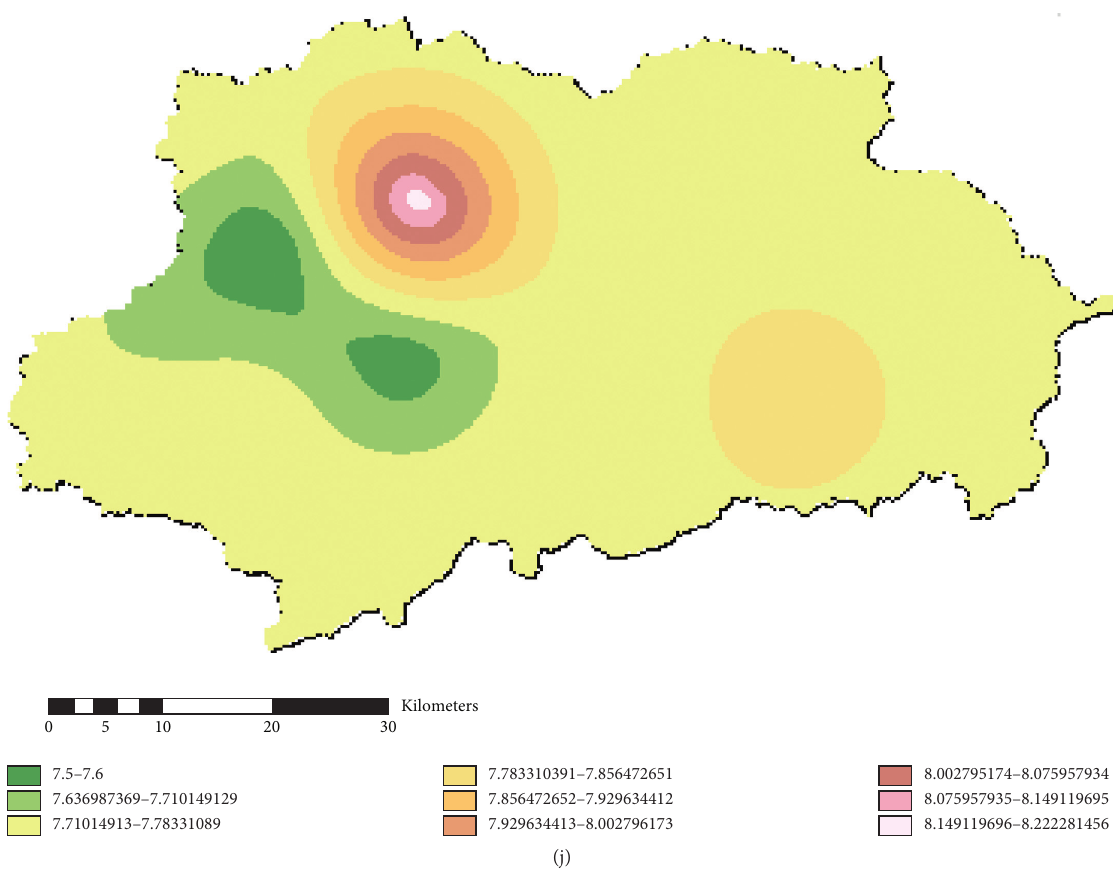
Figure 2: Mean annual variations of water quality parameters in the Nyando River basin from 2006–2011: (a) total phosphates; (b) total nitrates; (c) electrical conductivity; (d) turbidity; (e) pH; (f) temperature; (g) discharge; (h) total suspended solids (TSSs); (i) dissolved oxygen (the box plots denote 25th, 50 th , and 75th percentiles and the whiskers indicate the 5th and 95th percentiles). (j) Spatial distribution of DO concentration within the basin.